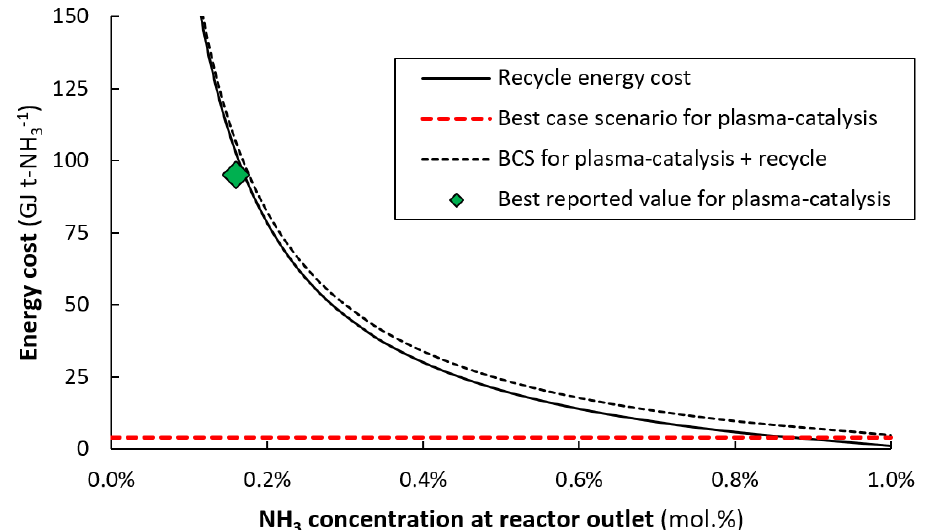
Figure 6. Energy cost of the recycle as a function of the ammonia concentration at the reaction outlet, as well as the best reported value for plasma catalysis, and a best-case scenario for plasma catalysis. The energy cost of recycling is estimated based on values reported by Smith et al. [67]. The best reported value for plasma catalysis is found in the data of Kim et al. [43].